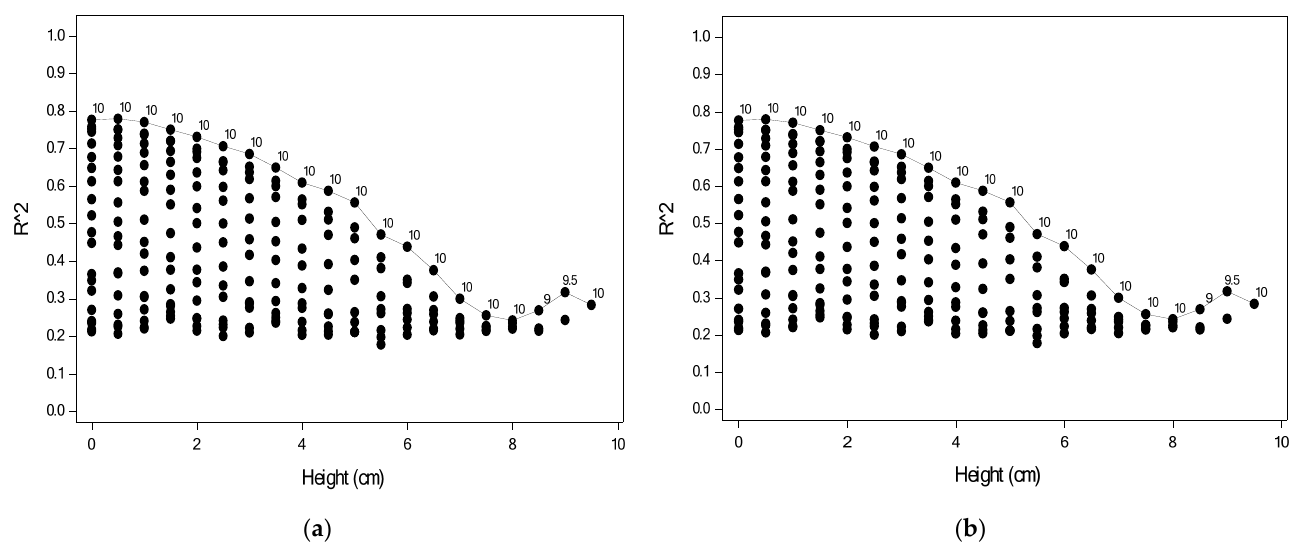
Figure 10. R 2 based on plantar pressures and personal features for 210 models for Module IIIb: ( a ) right foot; ( b ) left foot. Table 6. Regression models based on plantar pressure for two heights and personal features. Right